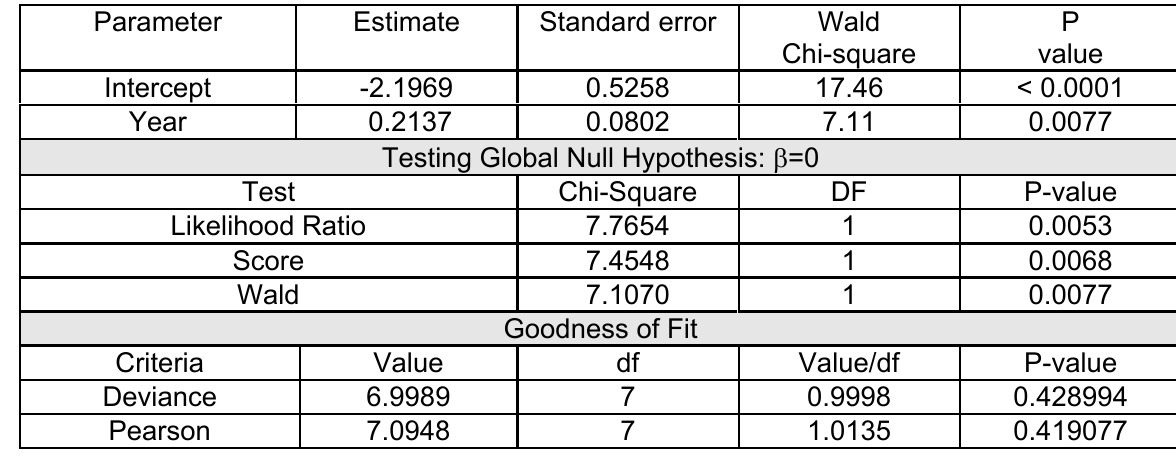
The quasi-likelihood logistic regression analysis